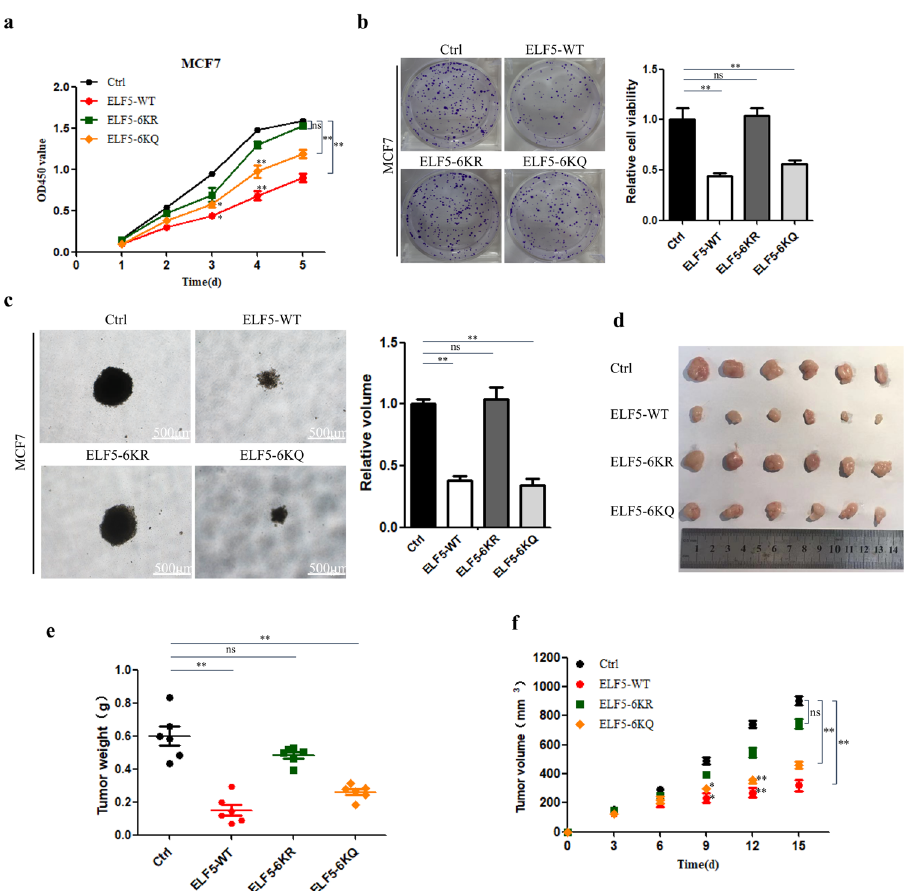
Fig. 6 Inhibition of breast cancer cell proliferation and tumorigenesis by ELF5 acetylation. a Growth curves of MCF7 cells that stably expressed GFP-ELF5 WT, GFP-ELF5 6KR, GFP-ELF5-6KQ as measured by CCK8 assay. Control cells were transfected with just the pEGFP-C1. Data are the means ± SDs from three determinations. * p < 0.05; ** p < 0.01; ns, no signi fi cance. b Colony formation of MCF7 cells that stably expressed GFP-ELF5 WT, GFP-ELF5 6KR, GFP-ELF5-6KQ as measured by crystal violet staining assay. Control MCF7 cells were transfected with just the vector pEGFP-C1. Data are the means ± SDs from three determinations. * p < 0.05; ** p < 0.01; ns, no signi fi cance. c Anchorage- independent growth activity of MCF7 cells as measured by soft-agar colony culture assay. Data are the means ± SDs from three determinations. * p < 0.05; ** p < 0.01; ns, no signi fi cance. d Image showing the tumor formed in xenograft mice. e , f Weight and growth of tumor induced in mice by subcutaneously implanted MCF7 cells (5 × 10 6 cells injected per mice) that stably expressed GFP-ELF5 WT,